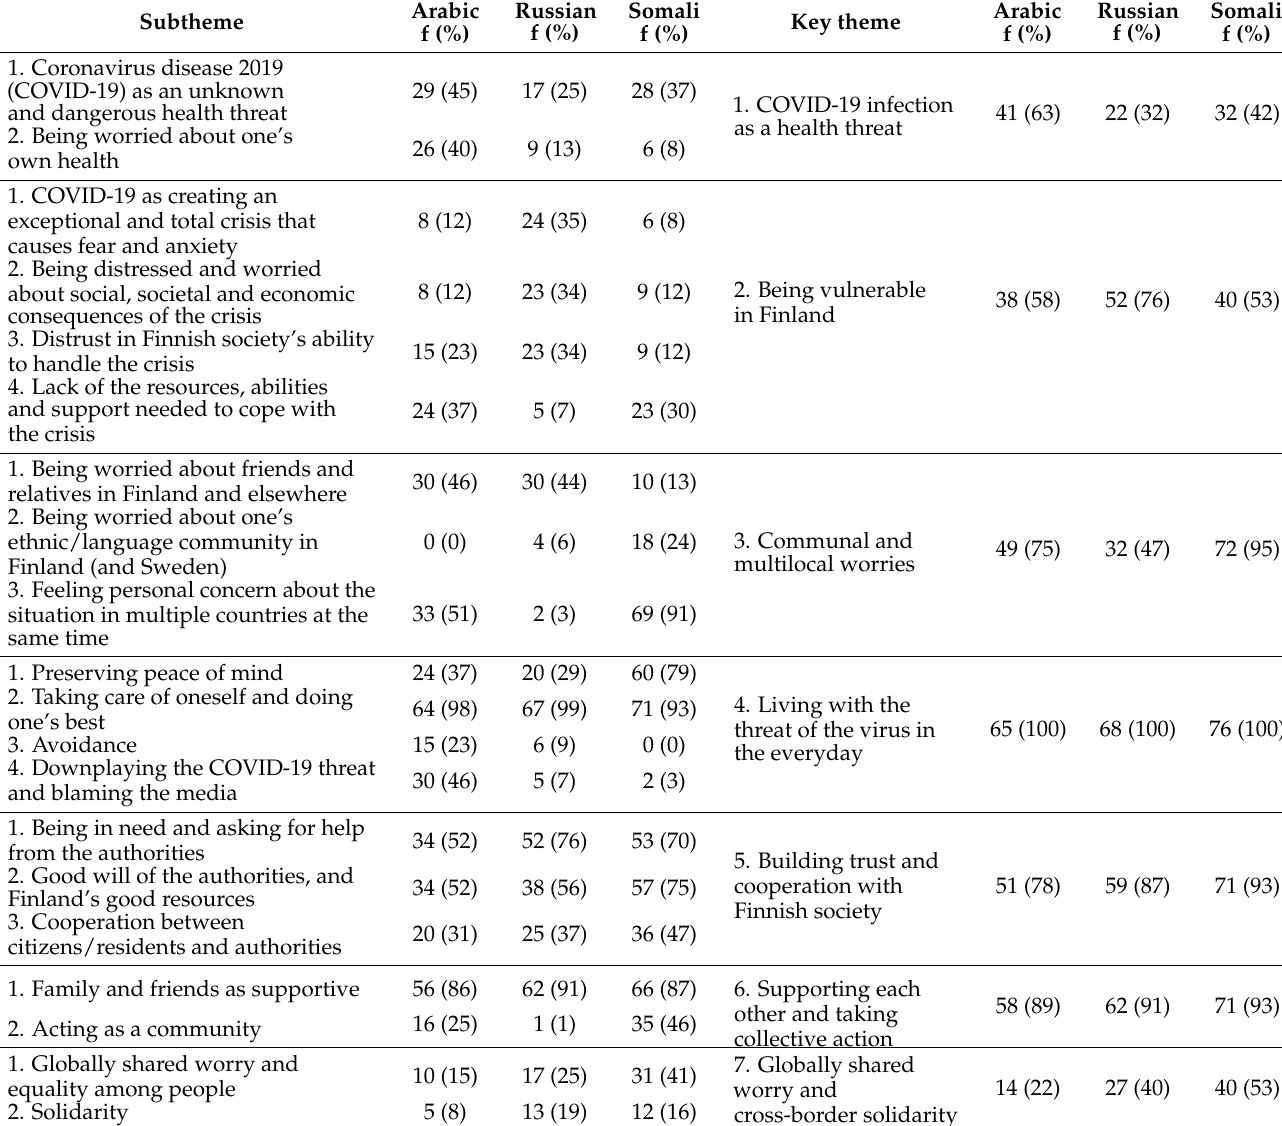
Table 2. Frequencies of subthemes and key themes per